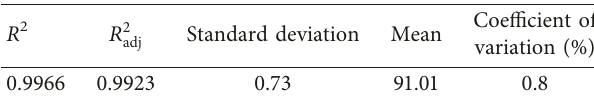
Table 5: Correlation of